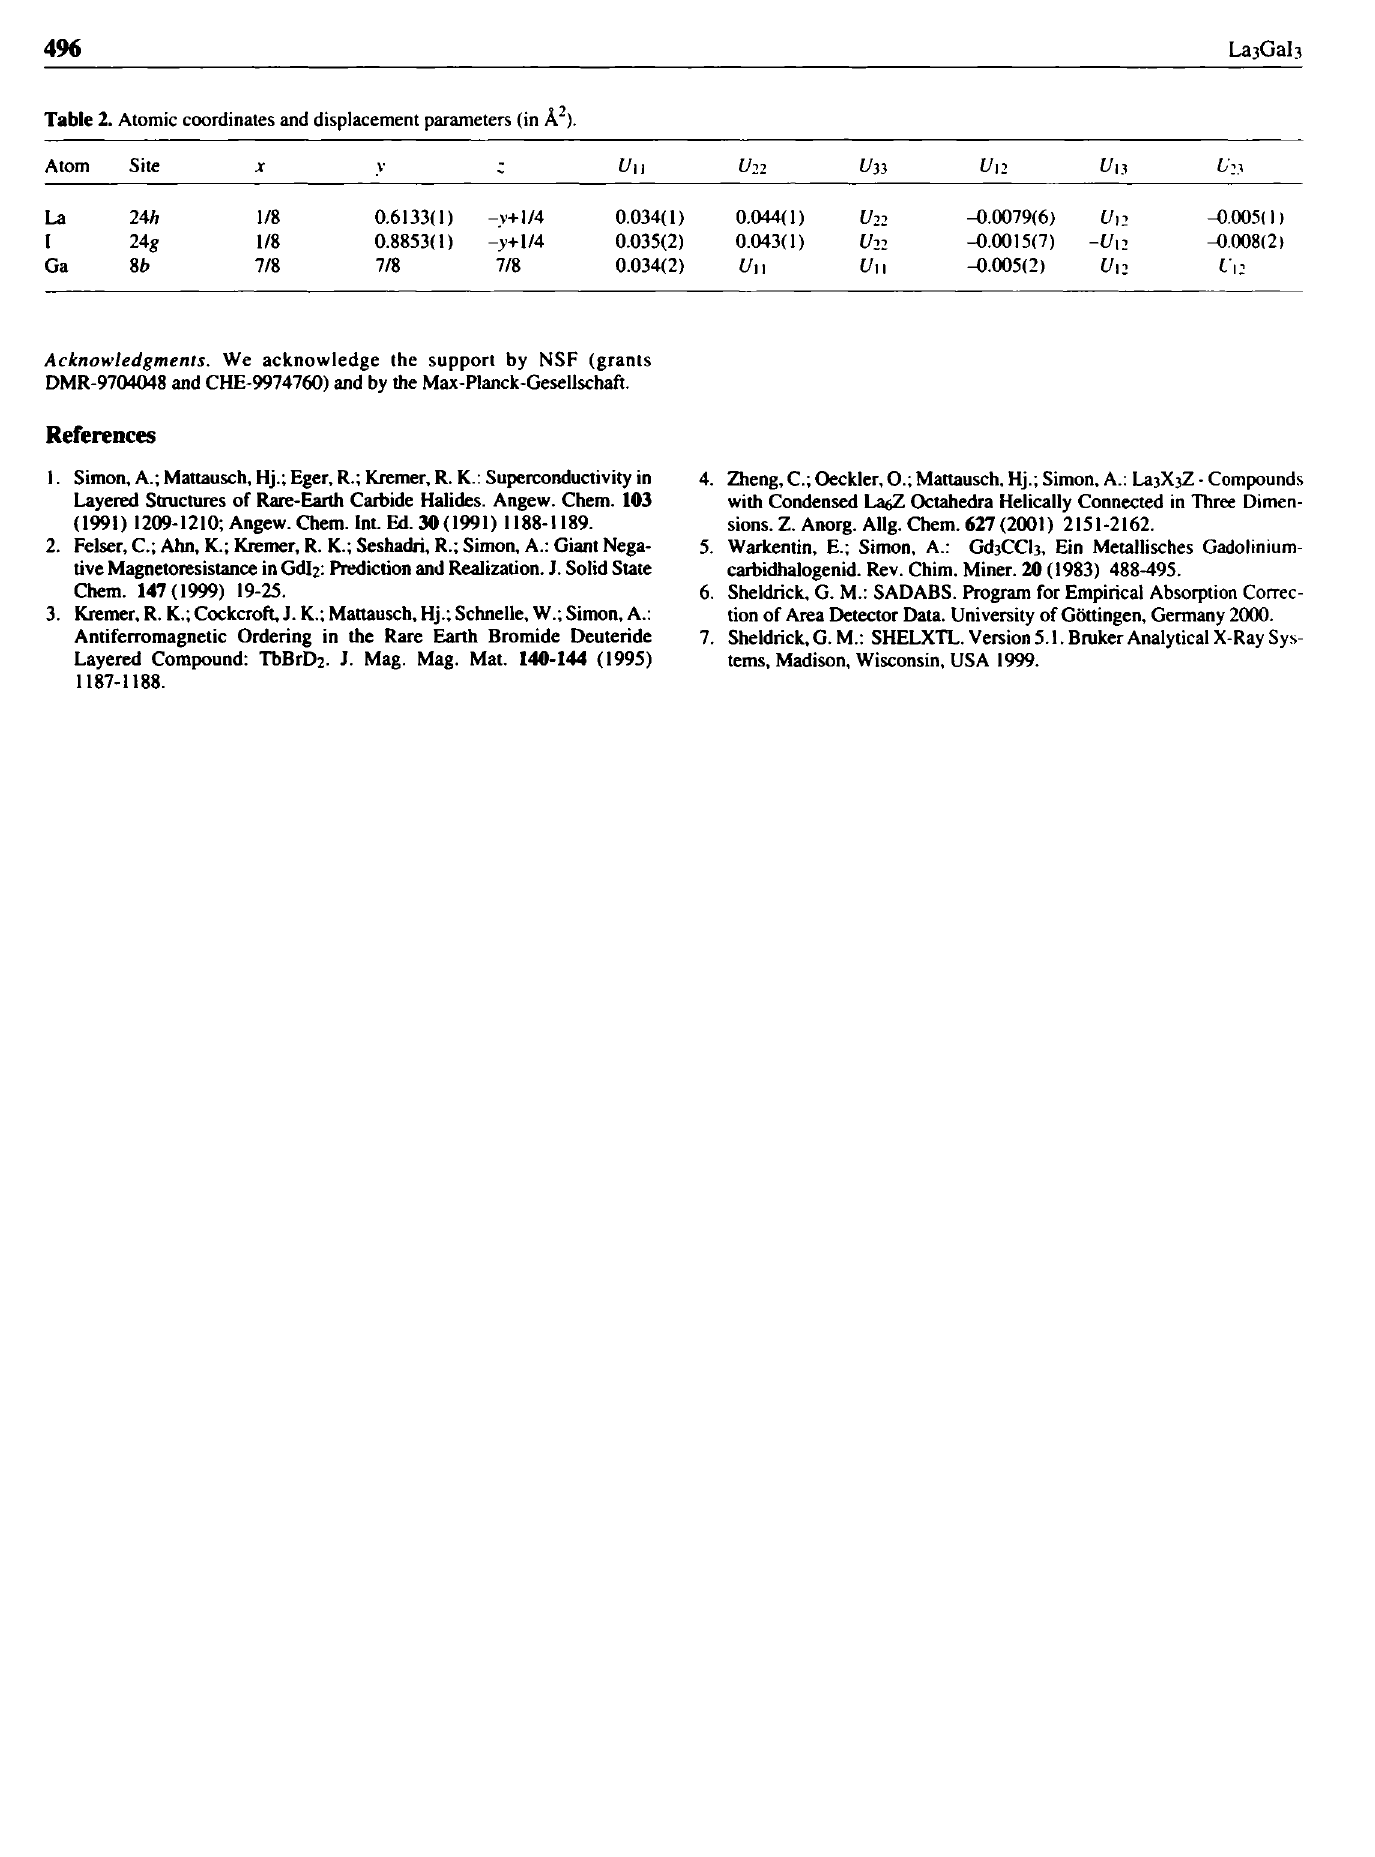
Table 2. Atomic coordinates and displacement parameters (in Ä 2